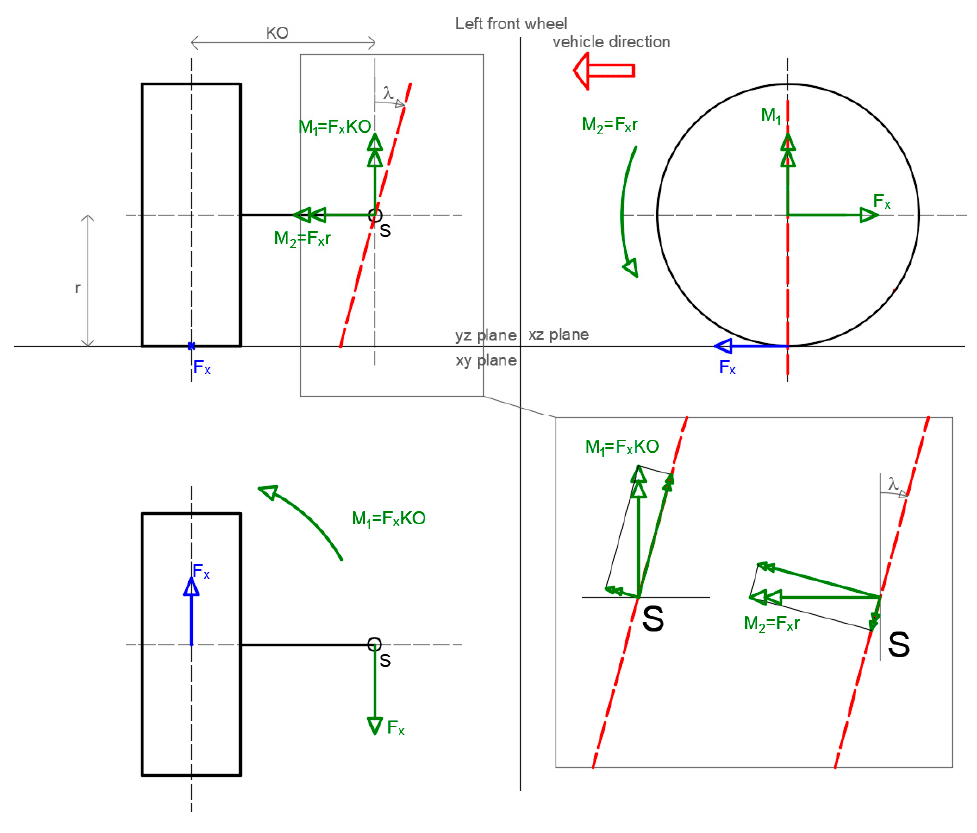
Figure 4. Case 2: kingpin angle > 0.